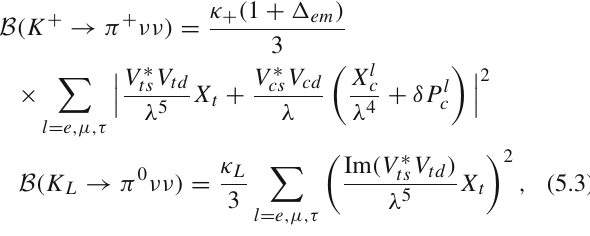
from Table 1 of [121]: X e ,μ = 11 . 18 × 10 − 4 , X τ = 7 . 63 × 10 − 4